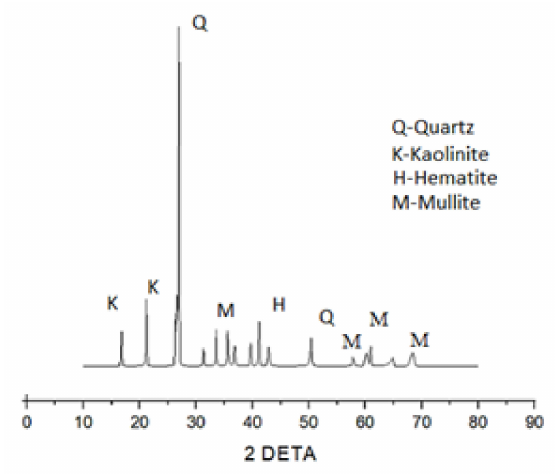
Figure 16. XRD for fly